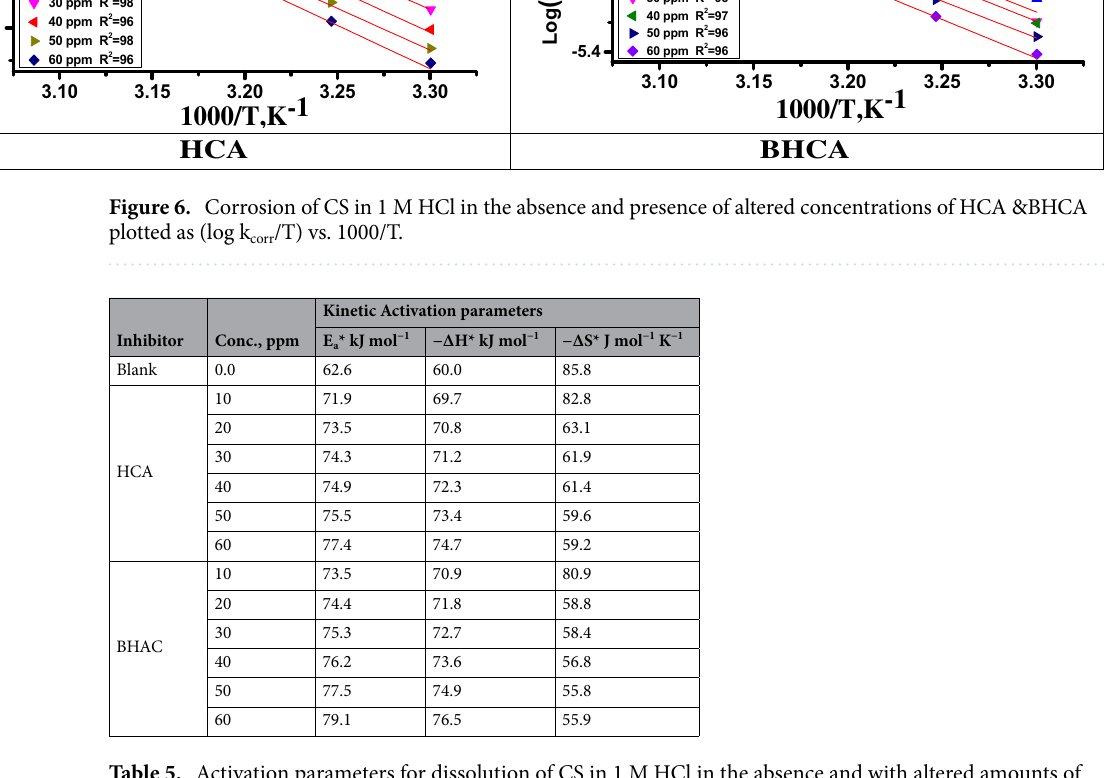
Table 5. Activation parameters for dissolution of CS in 1 M HCl in the absence and with altered amounts of HCA &BHCA.